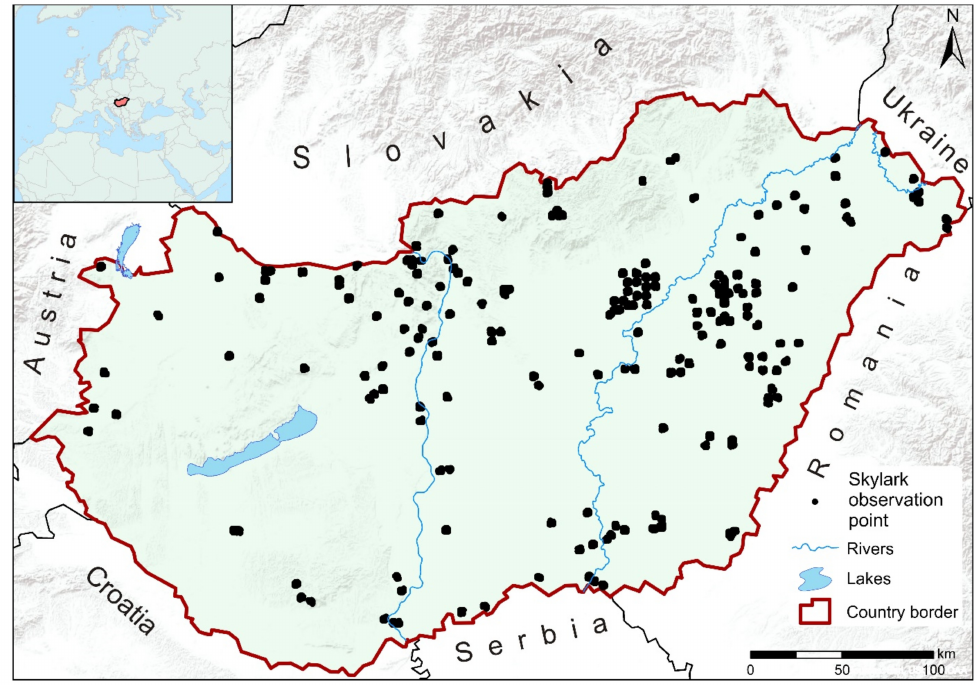
Figure 1. The spatial distribution of the MMM survey observation points in Hungary, where the Skylark occurred in 2015 (3049 observation